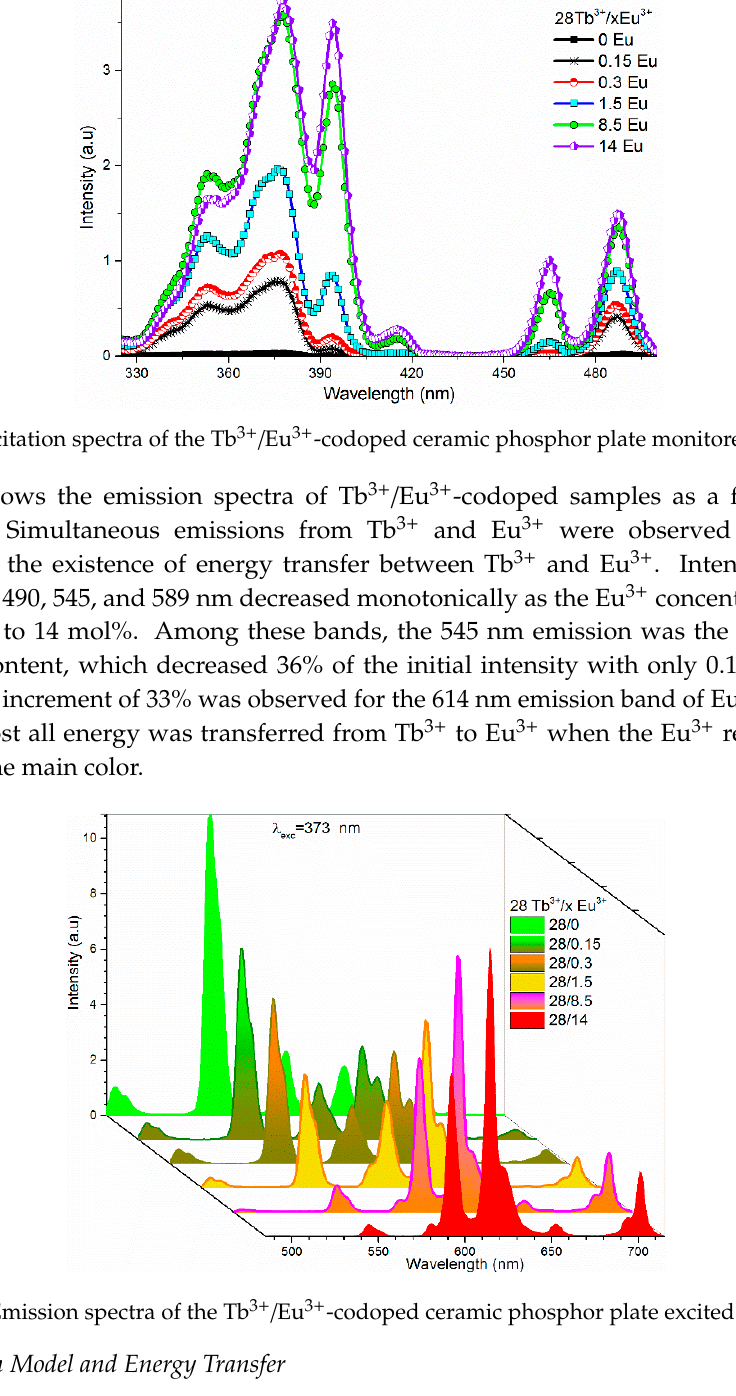
Figure 5. Schematic level diagram of Tb 3+ and Eu 3+ and the energy transfer mechanism. Therefore, the following ratio equations are proposed: 𝑑𝑁 (cid:3021)(cid:3029)(cid:2870) 𝑑𝑡 = 𝐴 (cid:2868)(cid:2870) 𝑁 (cid:3021)(cid:3029)(cid:2868) − 𝐴 (cid:2870)(cid:2869)